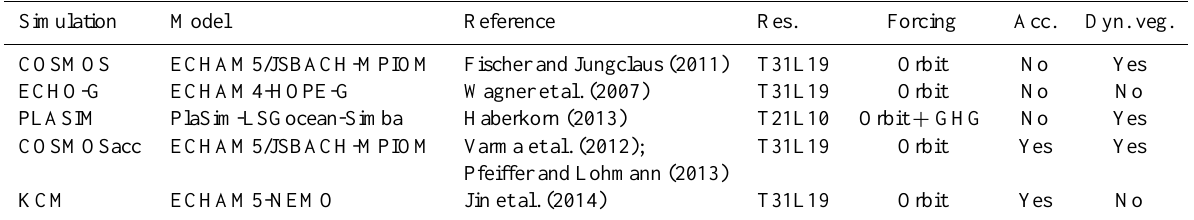
Table 1. Overview of all transient climate simulations considered in this study, including resolution (Res.), application of the forcing (Acc.), i.e. accelerated or not, and handling of dynamic vegetation in the model. Simulation Model Reference Res. Forcing Acc. COSMOS ECHAM5/JSBACH-MPIOM Fischer and Jungclaus (2011) T31L19 Orbit ECHO-G ECHAM4-HOPE-G Wagner et al. (2007) T31L19 Orbit PLASIM PlaSim-LSGocean-Simba Haberkorn